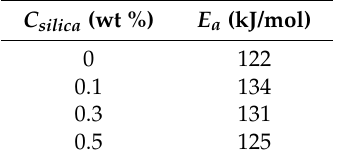
Figure 6. Arrhenius dependence of τ R with the reciprocal of absolute temperature for the NEWMS with different nanoparticle concentrations ( a ) 0 wt %; ( b ) 0.1 wt %; ( c ) 0.3 wt %; and ( d ) 0.5 wt %.